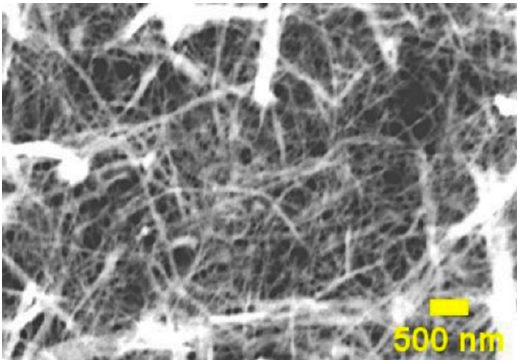
Figure 14. STEM image of NFC.